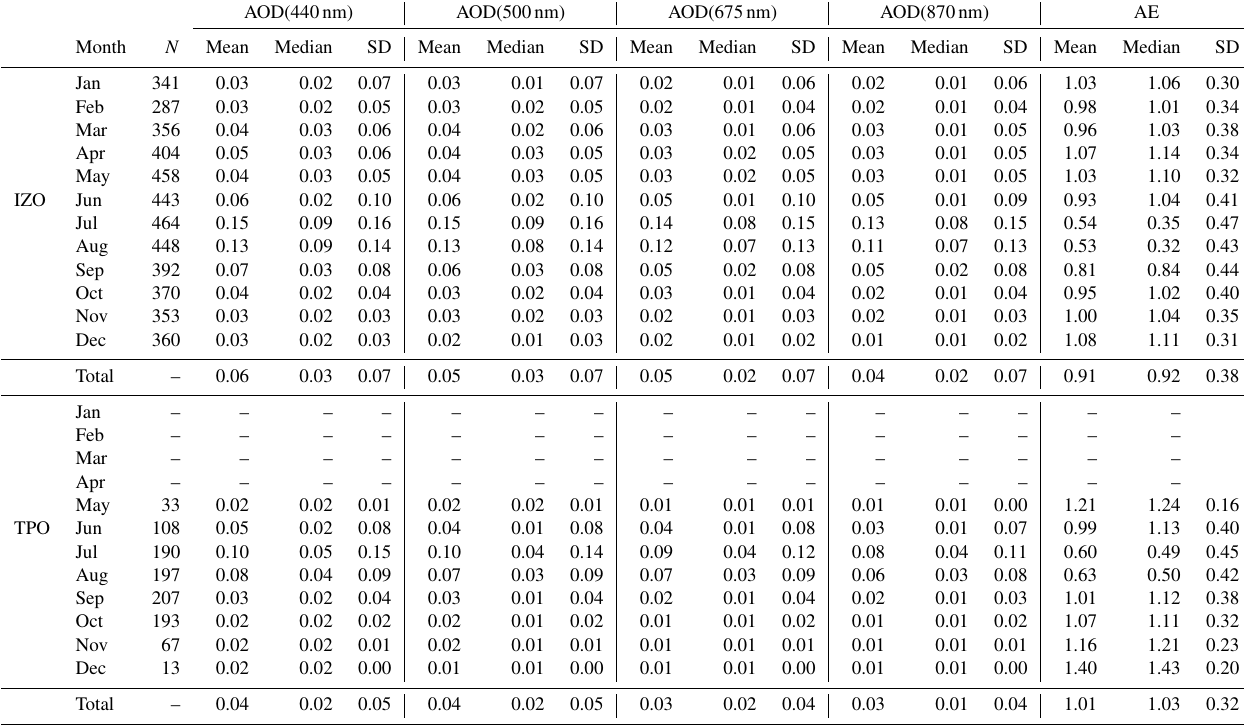
Table B1. Monthly mean, median and standard deviation (SD) of the aerosol optical depth (AOD) at 440, 500, 675 and 870nm and the Ångström exponent (AE 440 − 870nm ) at IZO between from October 2004 and December 2020 and at TPO between July 2012 and